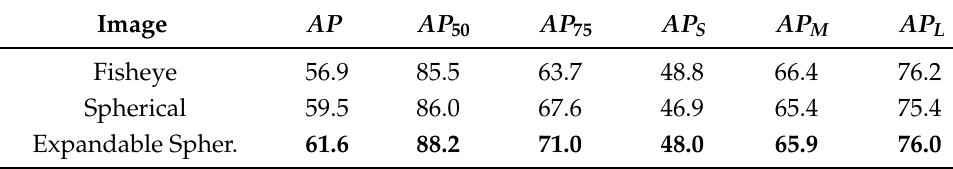
Table 4. Accuracy of different projections of SLCat model on the Fisheye-KITTI.